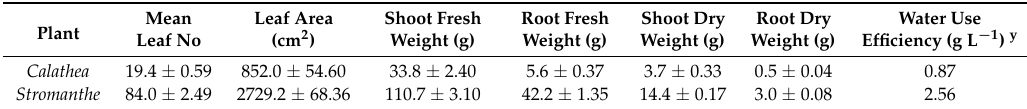
Figure 1. Growth indices (cm 3 ) of Calathea ‘Silhouette’ ( A ) and Stromanthe sanguinea ( B ) grown in 15 cm containers from tissue-cultured liners to marketable sizes. The equations are the best fit line (dash). Table 1. Plant growth measurements at harvest by species. Plants were harvested when common commercial canopy sizes were attained z .